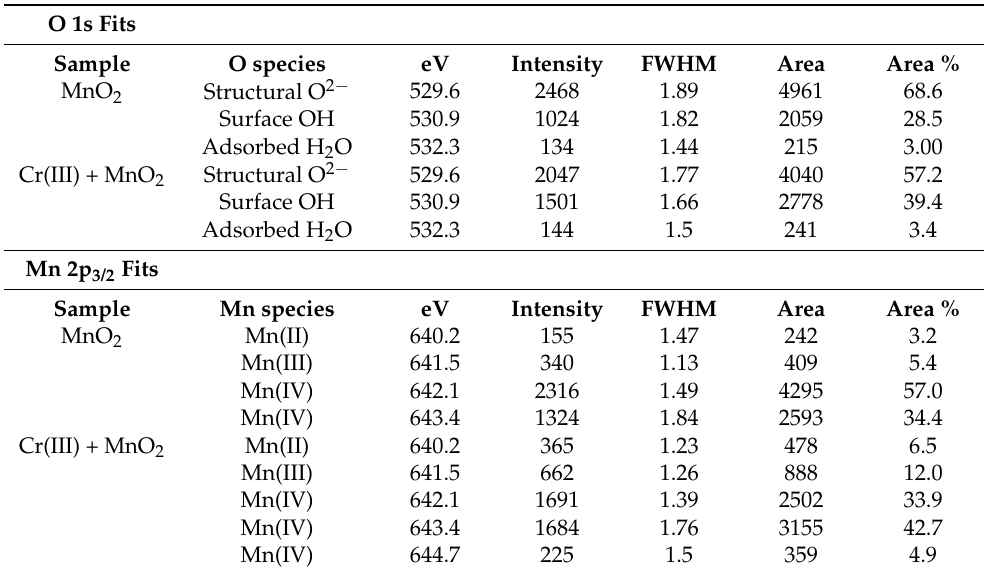
Table 1. O 1s and Mn 2p 3/2 X-ray photoelectron spectroscopy (XPS) peak-fit results for MnO 2 and Cr(III)-treated MnO 2